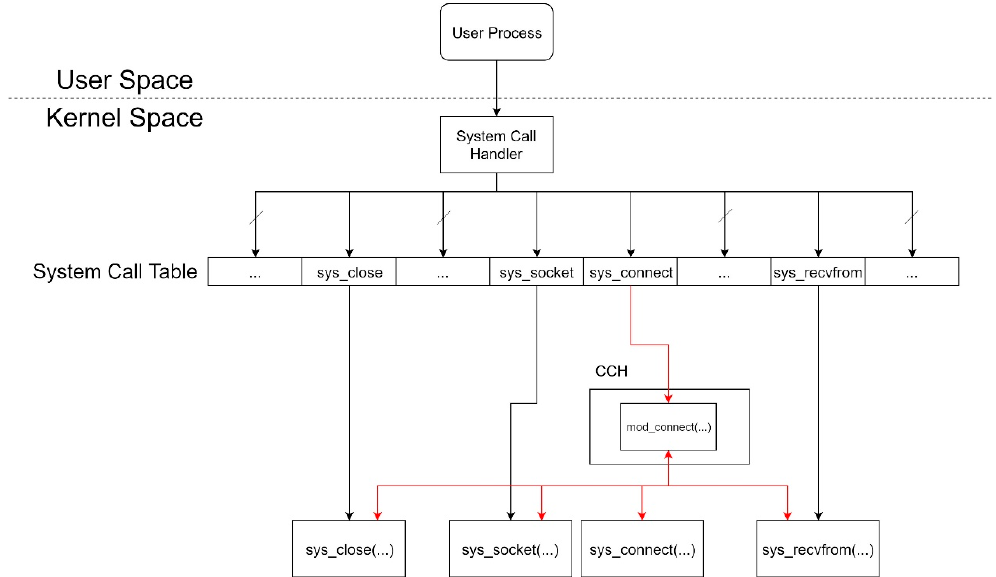
Figure 6. Workflow of Client Connection Handler (CCH).